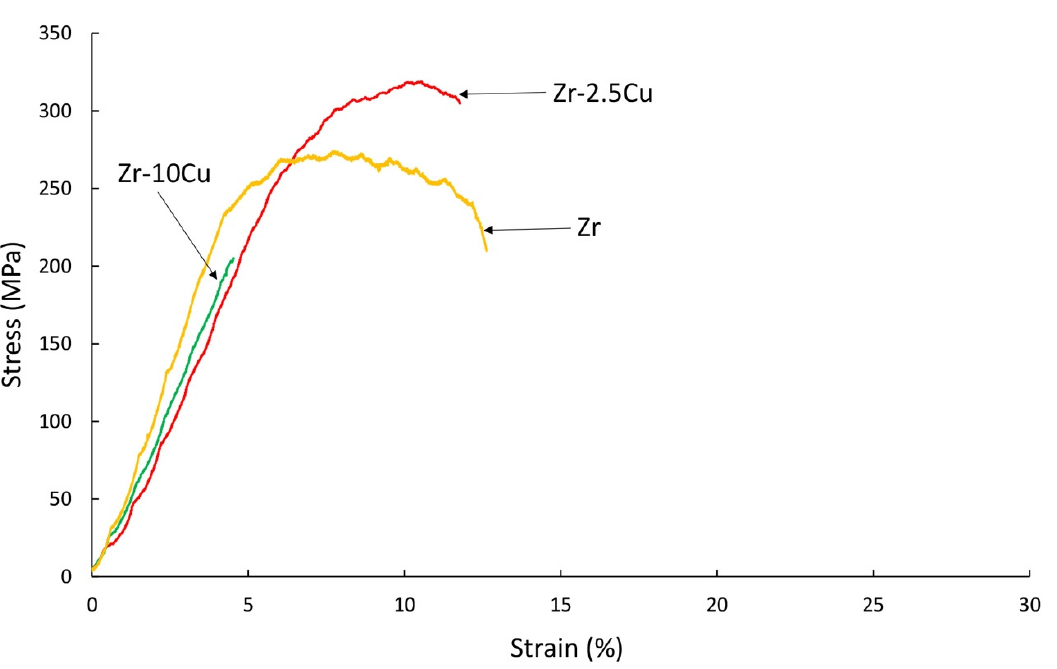
Figure 12. Fractography of tensile fracture surfaces for: ( A ) the extruded samples of Zr-2.5Cu and ( B ) Zr-10Cu.